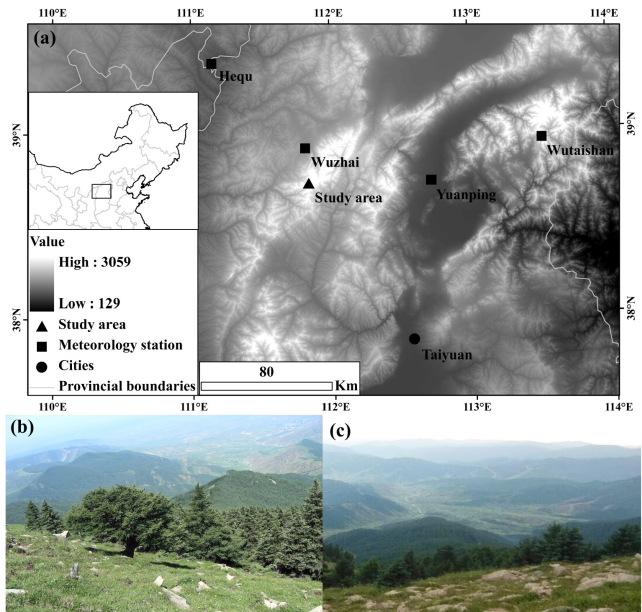
Figure 1. Location of the study area and meteorological stations ( a ), and photographic view of the study sites on north-facing ( b ) and south-facing slopes ( c